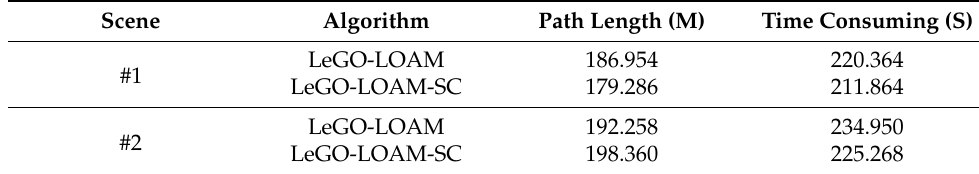
Table 4. Track length and time-consuming.